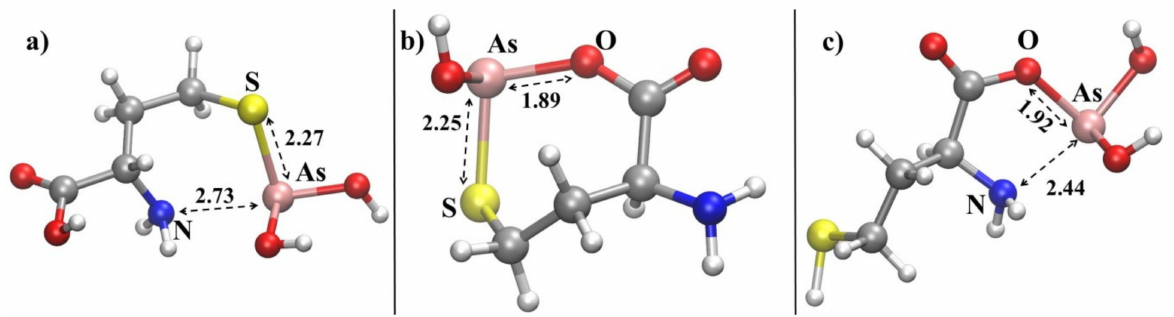
Figure 5. Molecular structures of the complexes formed by the two-to-one binding of As(III) with the thiol and amino ( a ), thiol and carboxylic ( b ), and amino and carboxylic ( c ) groups optimized at the B3LYP/6-311++G(d,p) under implicit solvation. Relevant optimal interatomic distances are shown in Å.